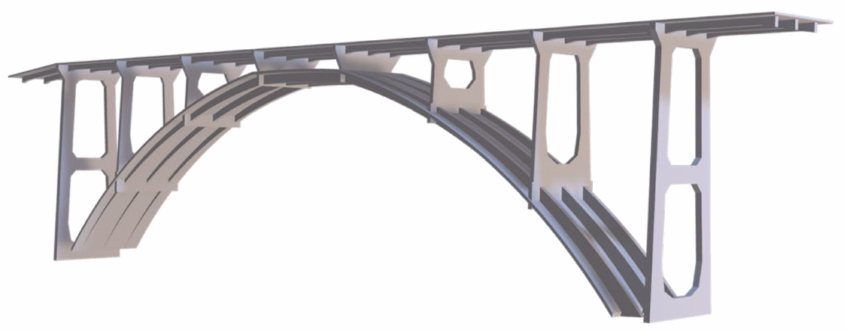
Figure 2. A 3D scheme of the penstock bridge on which the experimentation was performed.